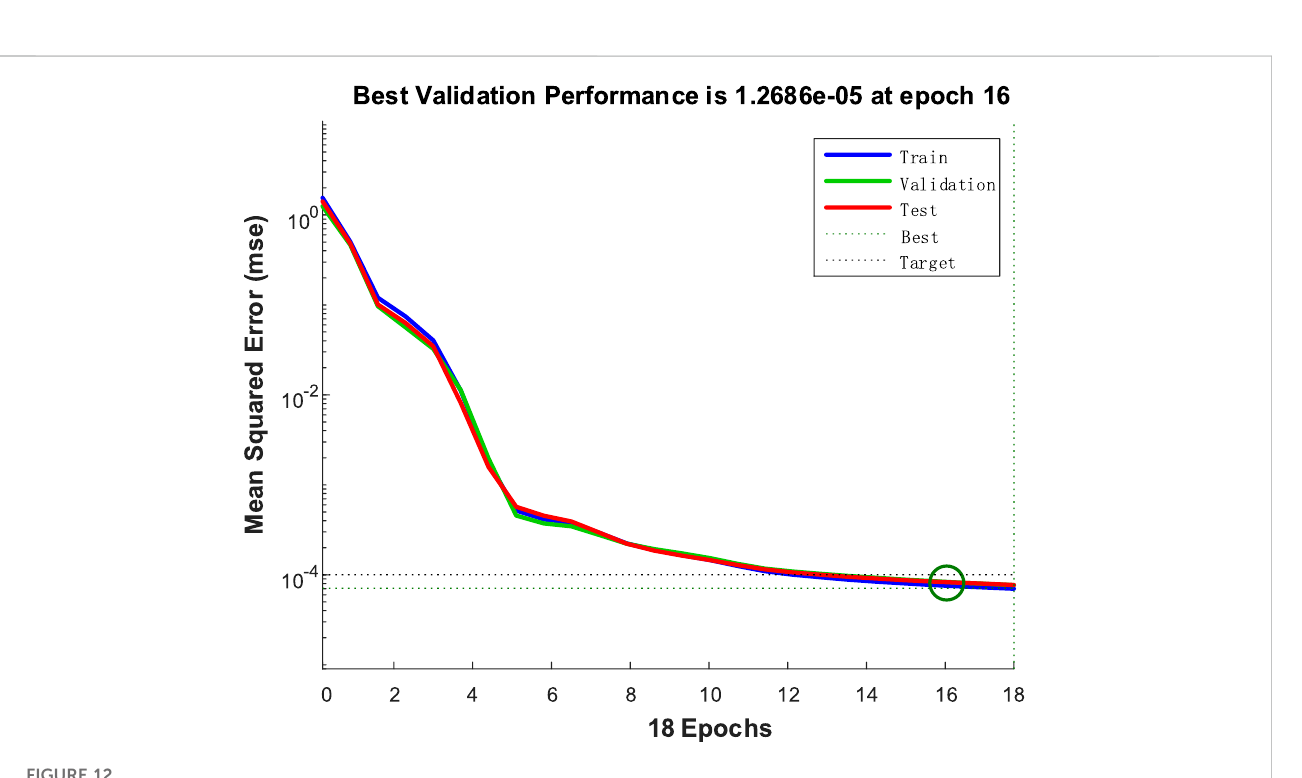
FIGURE 12 The training error of the evolutionary neural